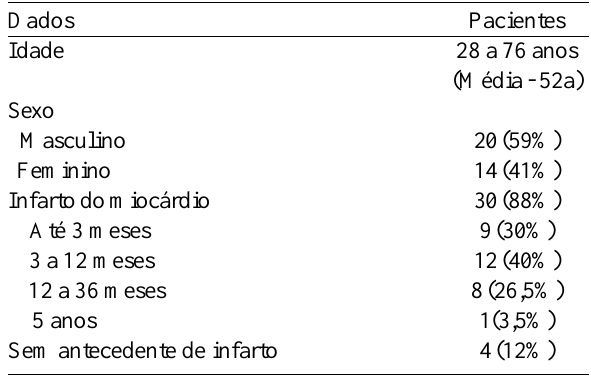
Tabela 1. Aspectos clínicos pré-operatórios.